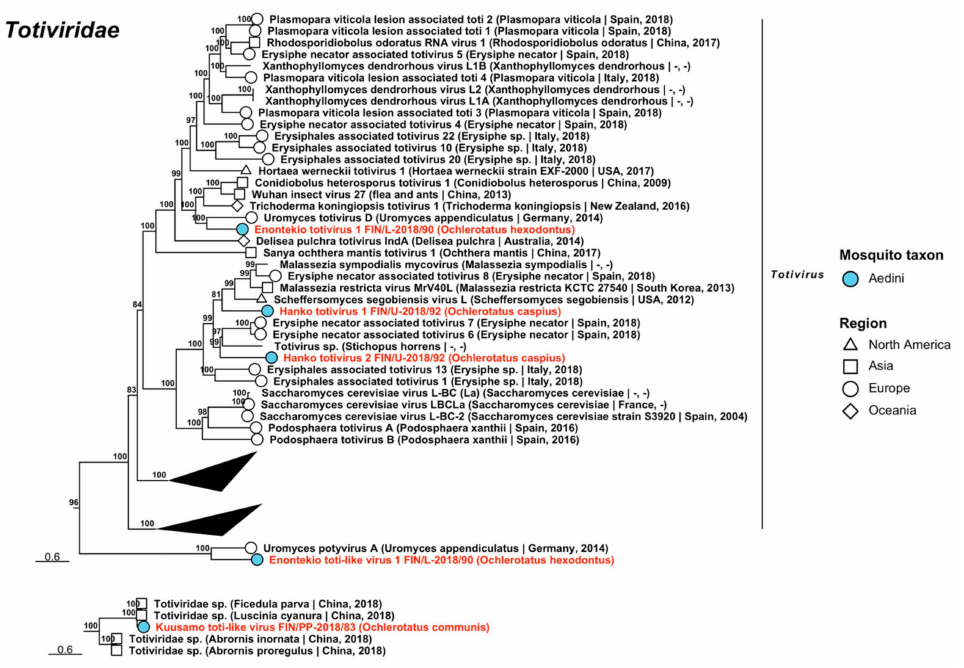
Figure 22. Maximum likelihood subtrees of Totiviridae . Tentative novel viruses are displayed in red and the mosquito species from which they were derived are in parentheses. Sequences from GenBank are black and display the following information after the virus or species name: “(sampled organism(s)|collection country, collection year)”. Tip colours represent the tribe of mosquito from which viruses were obtained. Tip shape represents the continent or region from which the specimens were collected. Trees were constructed from amino acid sequences of virus polymerases >1000 nt, aligned with MAFFT and computed with IQ-TREE2 using ModelFinder and 1000